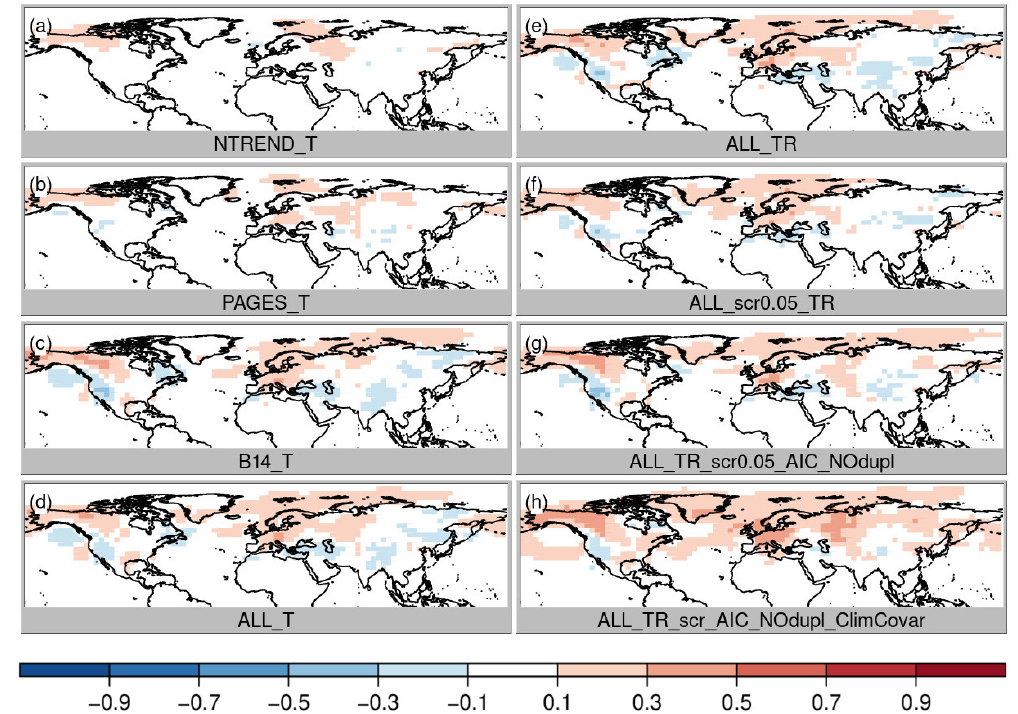
Figure 5. Same as Fig. 3 for sea-level pressure correlation, where red colors indicate an improvement of the